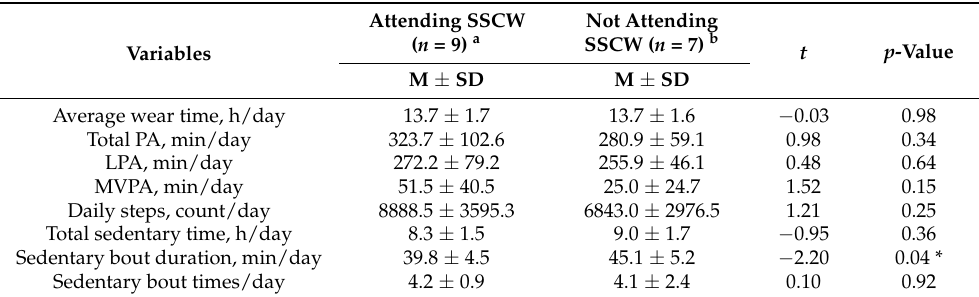
Table 4. Total amounts and patterns of physical activity and sedentary behavior in Prader-Willi syndrome adults with and without attending SSCW on